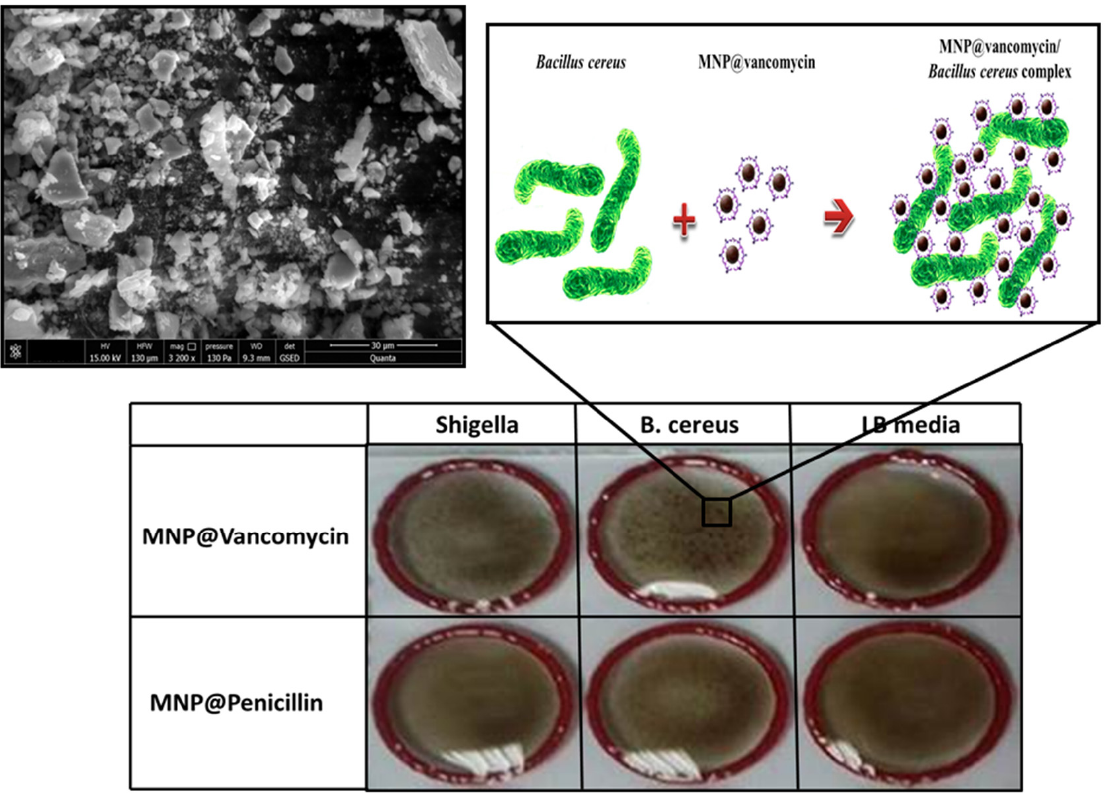
Figure 1. Scanning electron microscope image of the synthesized vancomycin-coated iron oxide magnetic nanoparticles (upper left panel). Schematic illustration of the MNP@antibiotic agglutination test (upper right panel). Evaluation of the interaction between two antibiotics, penicillin and vancomycin, stabilized magnetic beads with the two bacterial strains, B. cereus and S. flexneri , using the MNP@antibiotic agglutination test (lower panel).